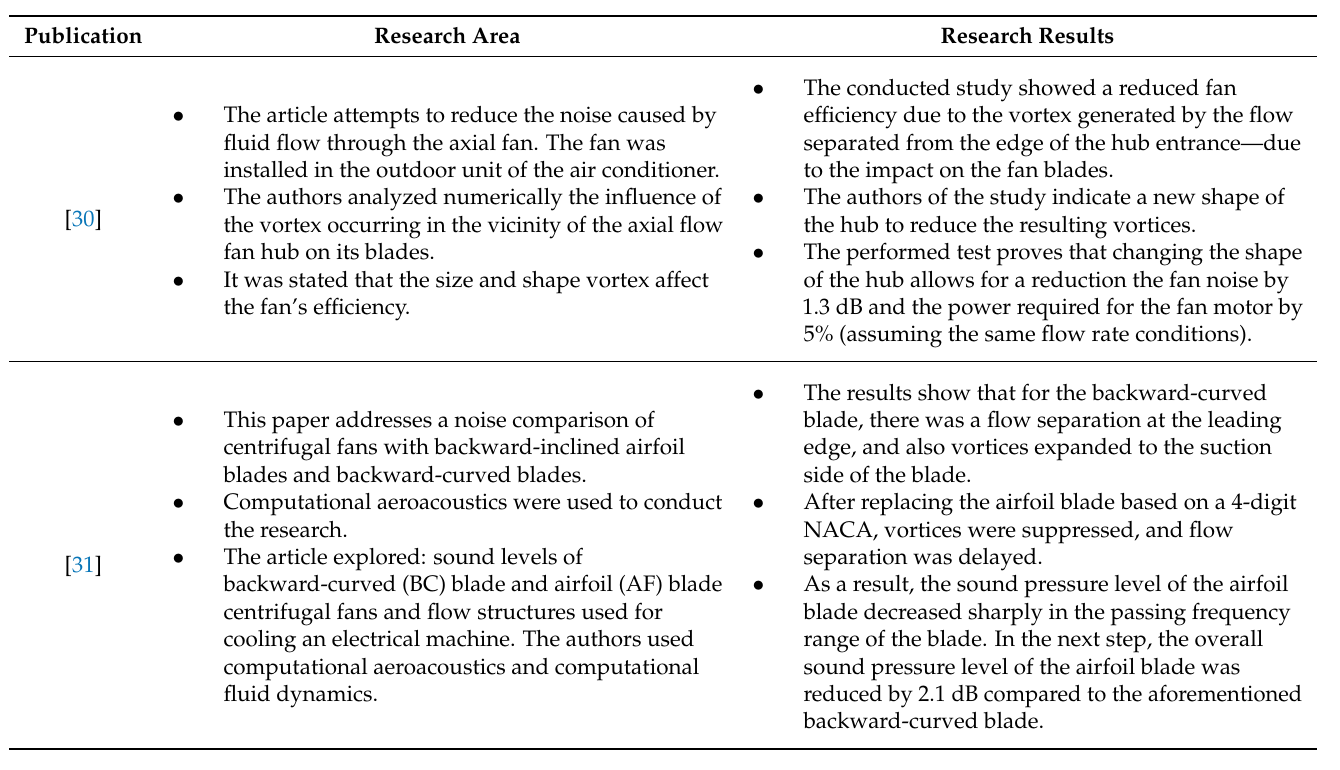
Table 2. Publications and activities related to the reduction of noise generated by